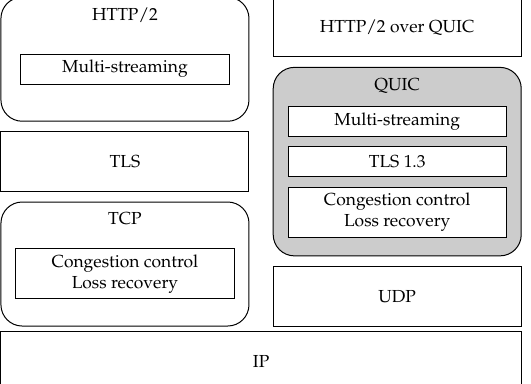
Figure 1. Traditional architecture of the transport layer TCP/TLS vs. the QUIC protocol stack.